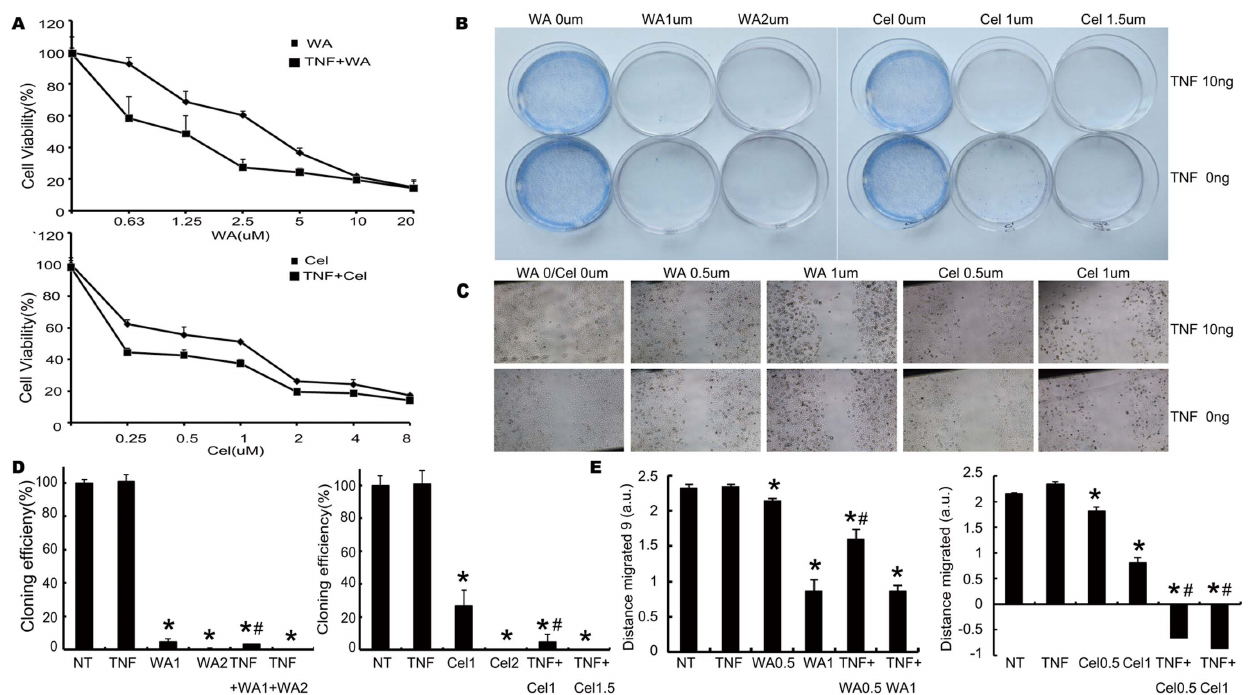
Figure 1. WA and Cel sensitize MDA-MB-231 cells to TNF- a resulting in inhibition of cell proliferation. (A) Concentration dependent effect of WA or Cel with or without TNF- a on cell viability. MDA-MB-231 cells were treated with different concentrations of WA (upper) or Cel (lower) with or without TNF- a (10 ng/ml) for 48 hours, followed by measurement of cell viability by MTTassay. IC 50 was calculated by Origin. (B) Colony formation assays of cells treated with WA or Cel with or without TNF- a . WA (left) or Cel (right) at shown concentrations with or without TNF- a (10 ng/ml) were added to the cells for 24 hours. The medium was subsequently removed and the cells were maintained in culture for a further 10 days. (C) Scratch wound-healing assay for cells treated with WA or Cel with or without TNF- a at shown concentrations. Photographs were taken at 24 hours after treatment and scratching of the well. (D) Colony forming efficiency was calculated. (E) Actual migration speed was calculated by Image-Pro plus. Data are shown as mean ¡ SD of three experiments. (*P , 0.05, versus the untreated group. # P , 0.05, WA/Cel treated versus WA/Cel + TNF- a